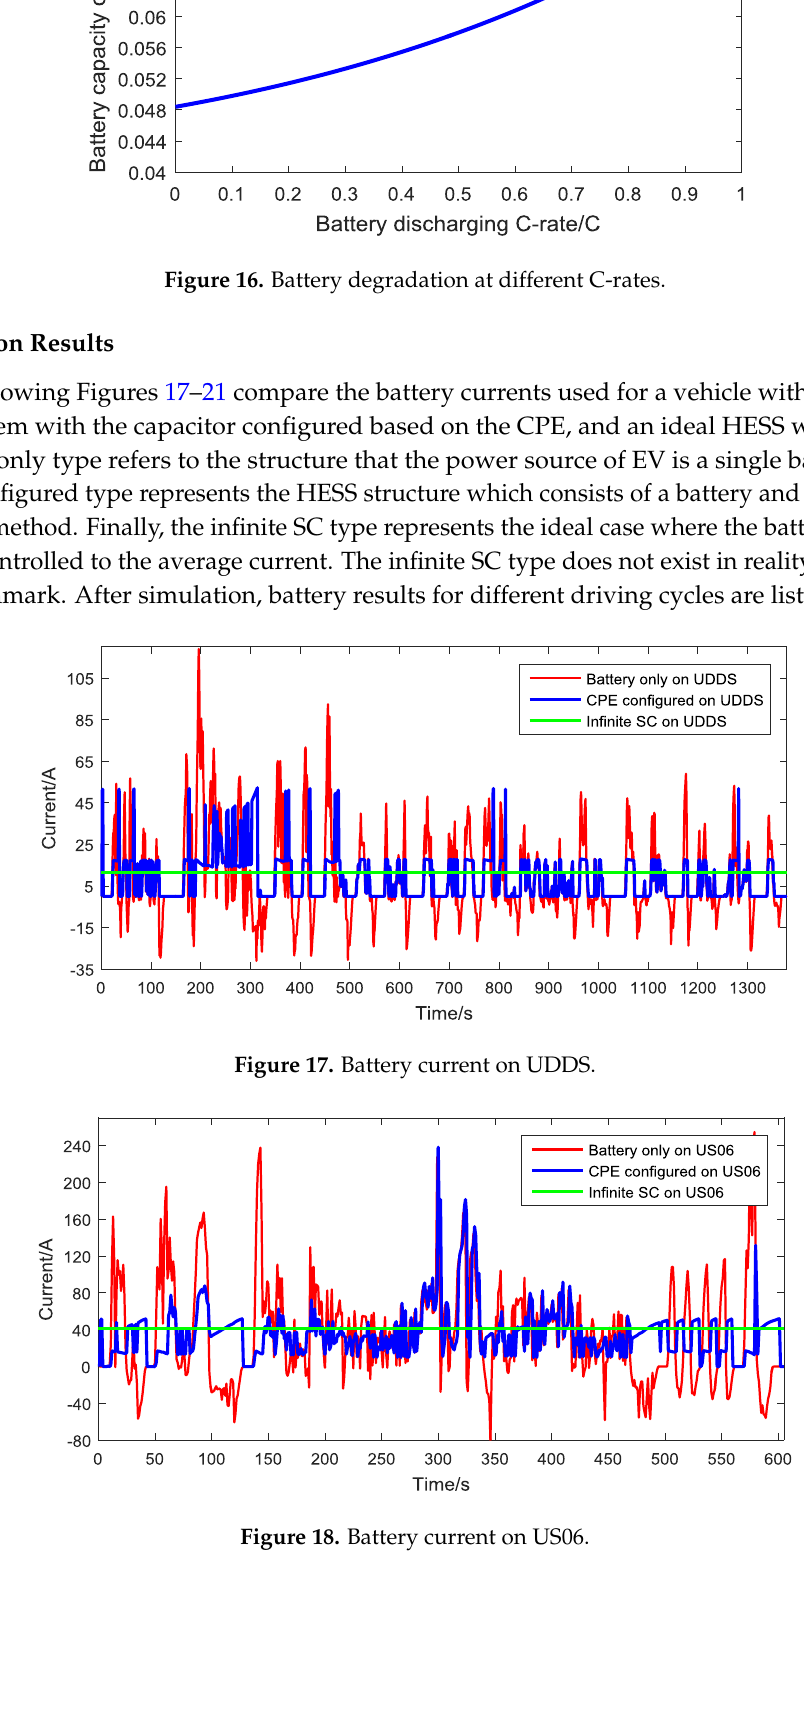
Figure 19. Battery current distribution on UDDS.